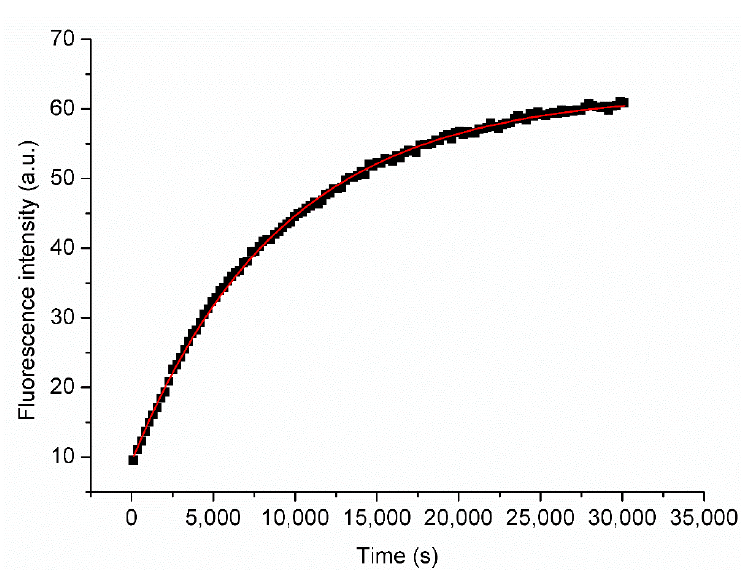
Figure 2. Representative kinetic profile of the release of CF 3 − from POPC/ β -CD liposomes at POPC/ β -CD = 5 and 25 ◦ C. The red curve is the fitting curve for a first order kinetics.